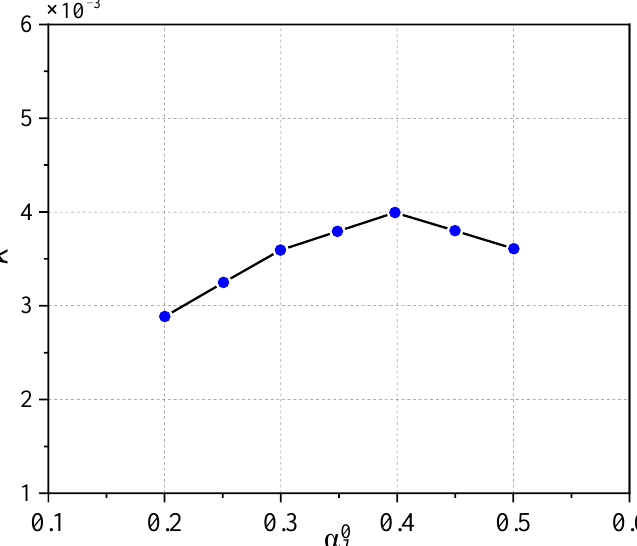
Figure 16. Relation between the slope of the line and the initial volume fraction of the liquid, where the initial volume fractions of the liquid are different.